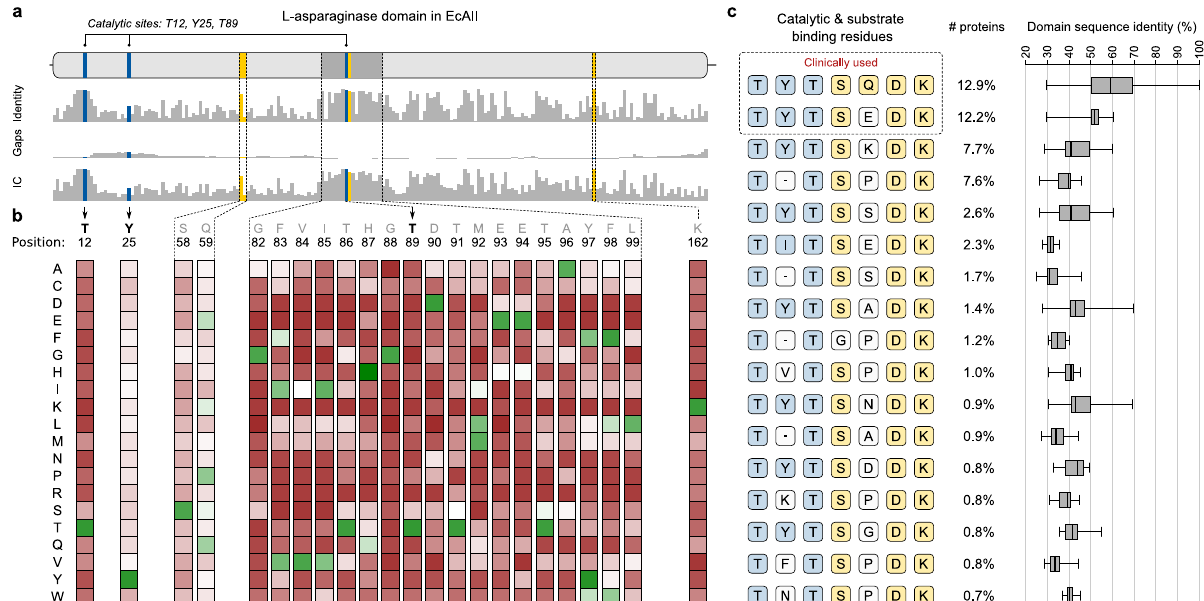
Figure 5. Sequence characteristics of l-asparaginase domain in bacterial AII proteins. (a) Amino acid conservation along the l-asparaginase domain between orthologs and the reference EcAII protein. The catalytic residues are marked by blue bars and substrate-binding residues are shown in yellow. The bar charts show identity percentage, gaps percentage and information content (IC) at each site. ( b) Position-specific score matrix (PSSM) calculated with reference to EcAII, showing how often a given residue is found at a specific position within the domain. Preferred residues (occurring more often than their expected frequency) are shown in green and avoided amino acids (occurring less often than their expected frequency) are shown in red. The complete PSSM profile across all l-asparaginase domain sites is shown in Table S12. (c) Most common arrangements of structurally and functionally important amino acid residues—catalytic (blue) and substrate binding (yellow)— found in bacterial AII proteins. The first two residue patterns are present in clinical drugs used to treat ALL ( E. coli strain K12 and Erwinia chrysanthemi ). The percentage numbers indicate the fraction of AII proteins containing a given residue pattern. Box plots (on the right) show sequence identity distribution of the full-length AII l-asparaginase domain across orthologs containing a given residue pattern. The box plot with sequence identity statistics of the whole l-asparaginase domain may be interpreted as a proxy of a dispersal range of a given motif among diverse